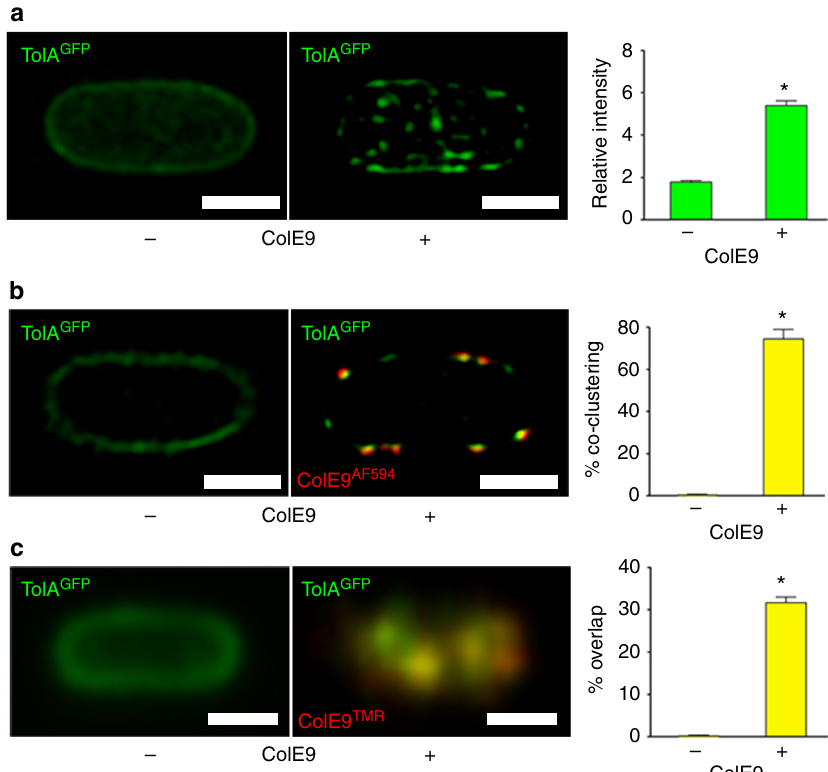
Fig. 2 Bacteriocin-induced clustering of TolA in the IM mirrors that of OMPs. a Typical 3D-SIM images of E . coli JW0729/pNP4, pRP5 cells expressing GFP-TolA (not induced) and BtuB (induced), respectively, showing how formation of a transenvelope complex by ColE9 induces clustering of TolA in the IM. b 2D-SIM z -slice showing signi fi cant co-clustering (yellow fl uorescence) of GFP-TolA and ColE9 AF594 in the IM and OM, respectively, along with quantitation of the degree of co-clustering in the accompanying histogram. c TIRFM data showing co-localisation of GFP-TolA clusters in the IM and OMP- bound ColE9 TMR islands (yellow fl uorescence) along with quantitation of the degree of overlap in the accompanying histogram. Scale bars, 1 μ m. Asterisk, p < 0.01 from a Student ’ s t test for n = 30 cells in each of the histograms shown. See Methods for